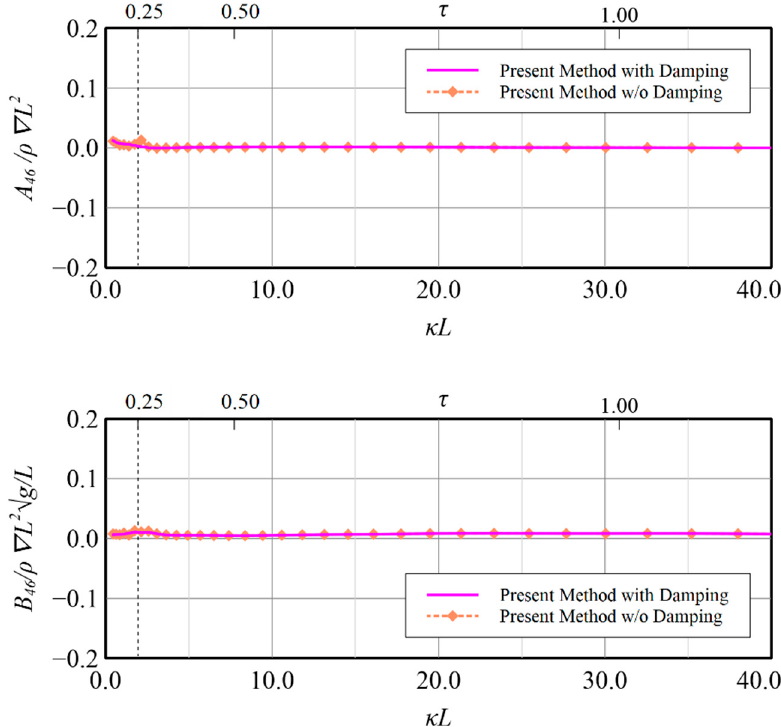
Figure 26. Yaw-induced-roll added mass and damping coefficient at F r = 0.18.